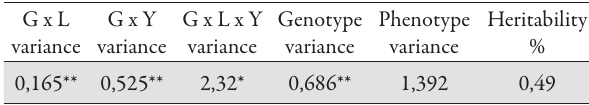
Tab. 7. Tab II. Components of variance and broad sense heritability (h 2 ) of percentage of black